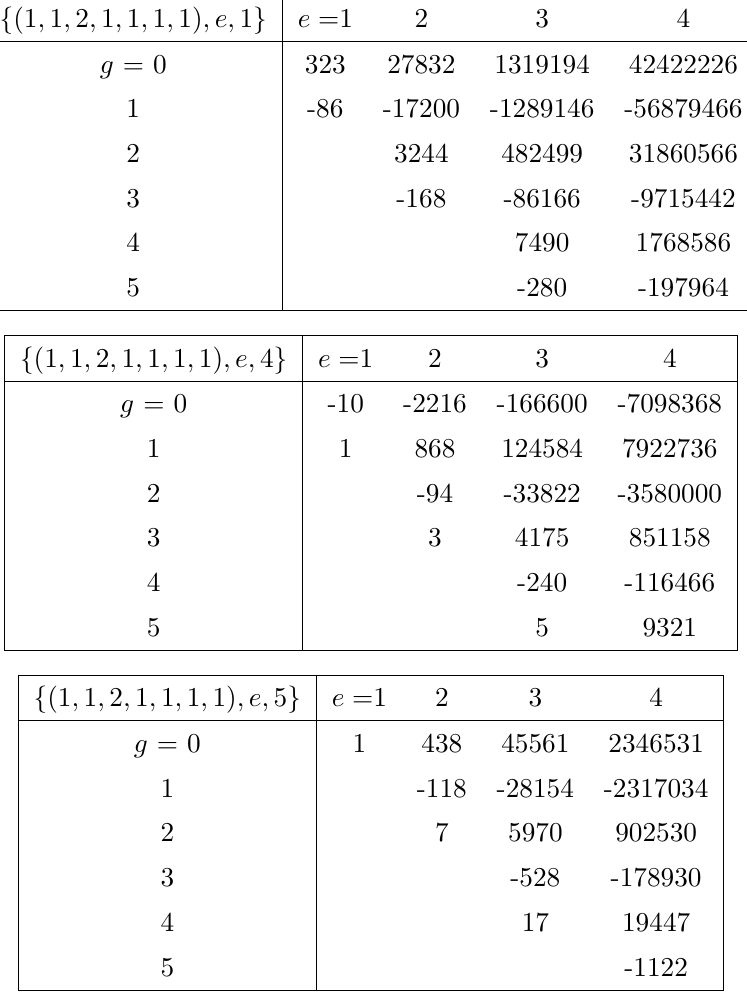
Table 11 . Unrefined GV invariants from (2,0) E 7 SCFT at base degree (1,1,2,1,1,1,1), fiber degree 1 to 4 and mass degree 1, 4 and